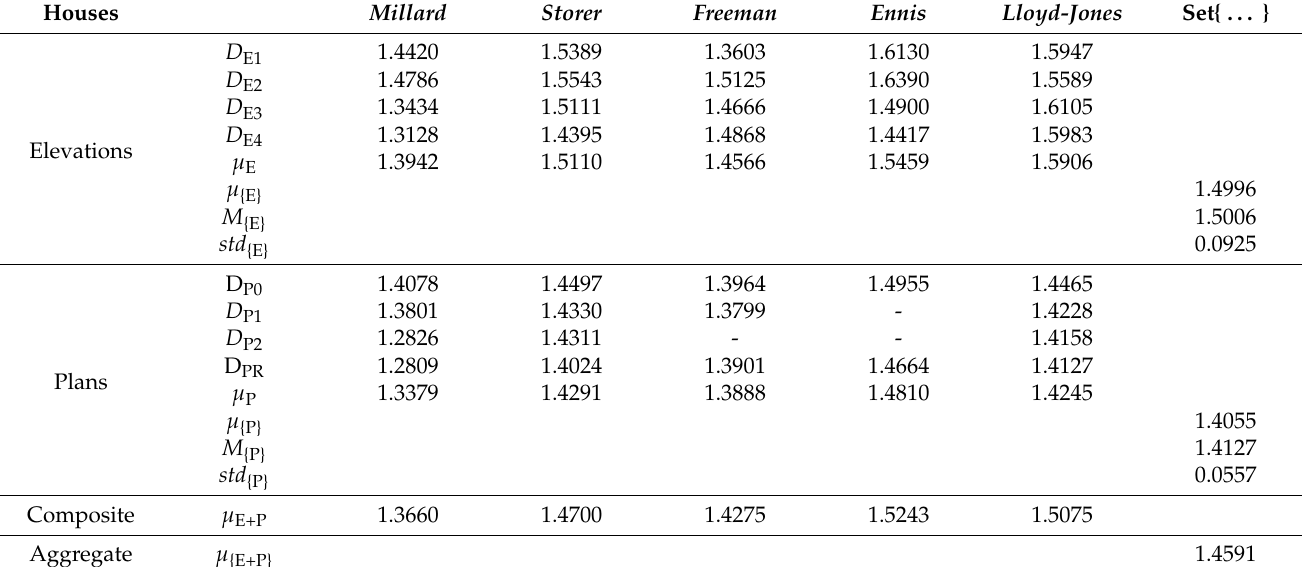
Table A2. Textile-Block set results.